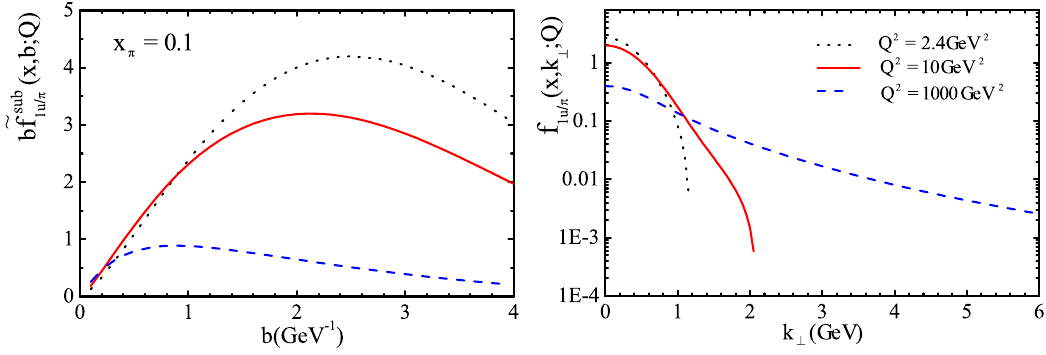
Figure 2 . Subtracted unpolarized TMD distribution of the pion meson for valence quarks in b - space (left panel) and k ? -space (right panel), at energies: Q 2 = 2 : 4 GeV 2 (dotted lines), Q 2 = 10 GeV 2 (solid lines) and Q 2 = 1000 GeV 2 (dashed